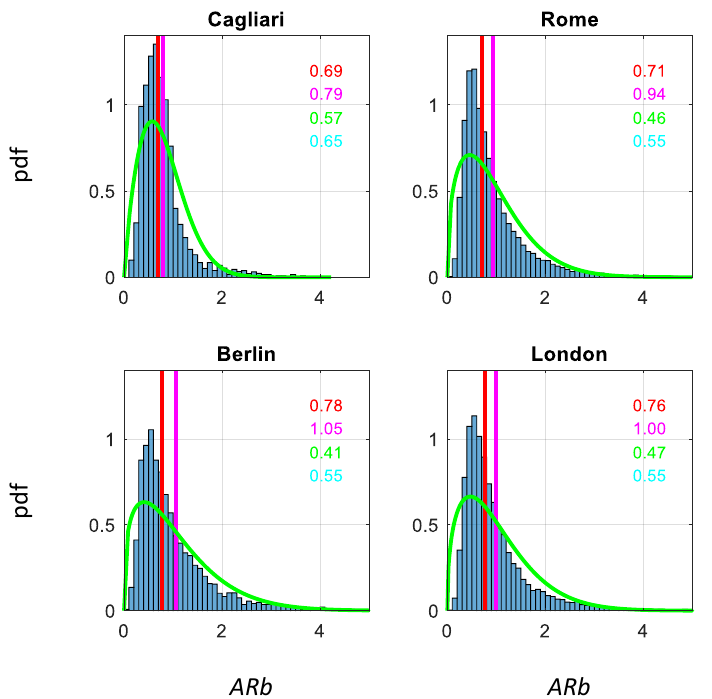
Figure 8. Pdf (ordinates) of ARb (abscissa) for each of the case studies; the red line highlights the average value, the magenta line the median value, the green line the best-fit Weibull distribution; on the legend, in red the average value, in magenta the median value, in green the most probable value of the best-fit distribution and in cyan the most probable value of the data.